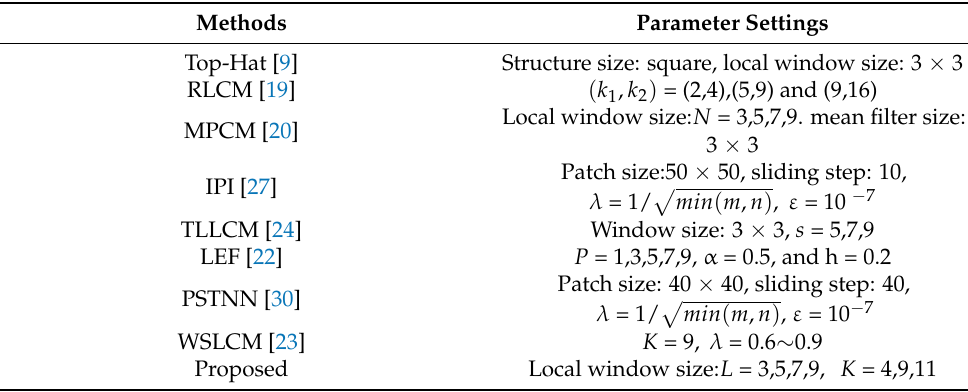
Table 2. Parameter settings of the different